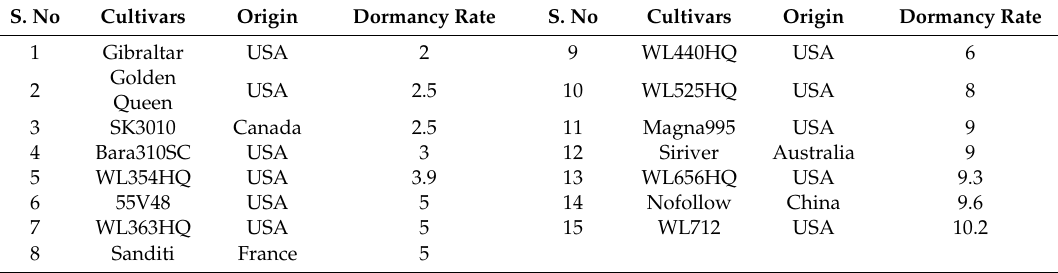
Table 1. Alfalfa cultivars used in the